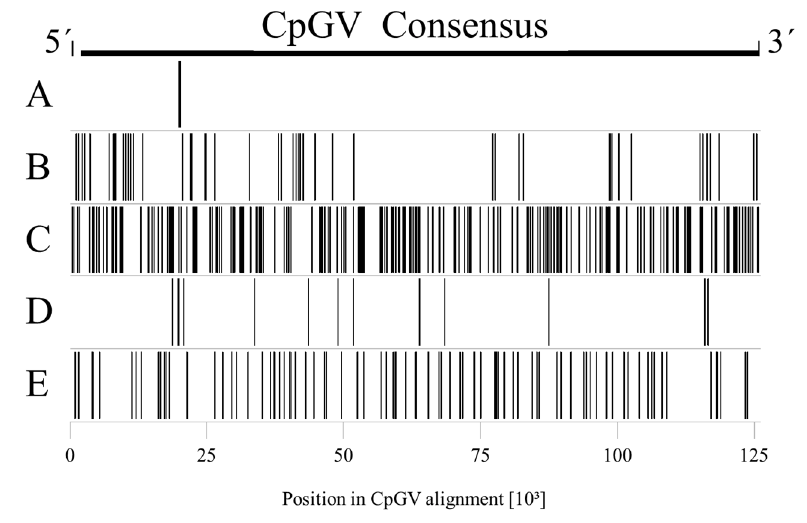
Figure 3. Distribution of SNPs specific to one of the five genome groups A to E of the CpGV whole genome alignment. Genome groups are indicated to the left, SNPs are represented by bars along the relative genome positions in the CpGV consensus sequence. Genome group A carries two SNPs, genome group B 54 SNPs, genome group C 356 SNPs, genome group D 21 SNPs, and genome group E 101 SNPs.